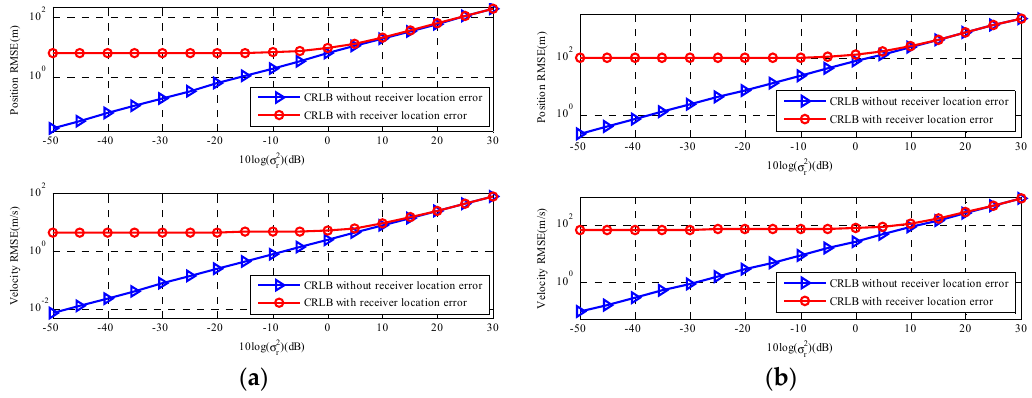
σ . ( a ) The near-field moving source; ( b ) r